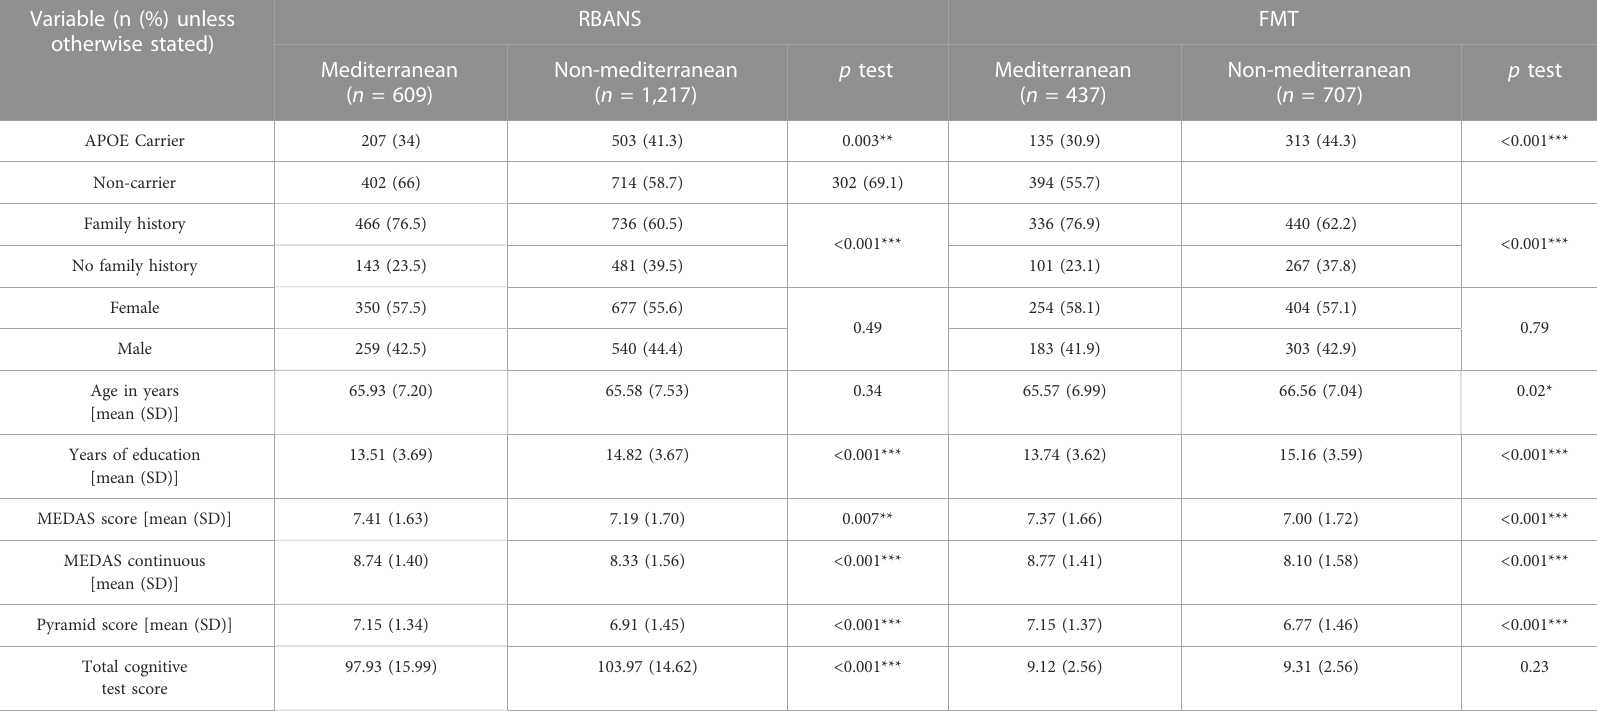
TABLE 3 Comparison of descriptive statistics between participants living in Mediterranean and non-Mediterranean countries * p < 0.05; *** p < 0.001. Variable (n (%) unless otherwise